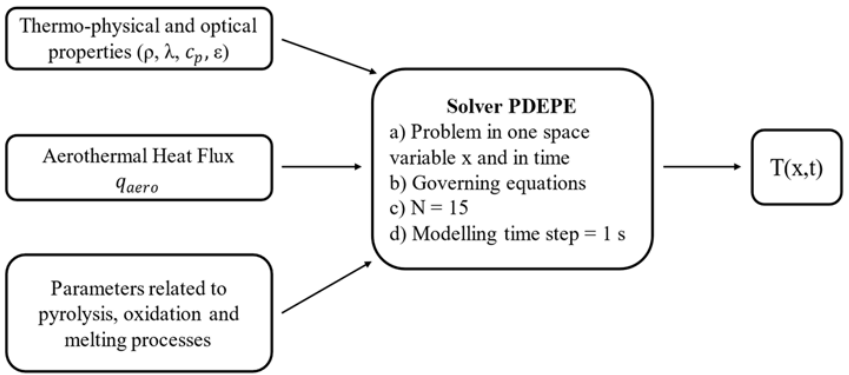
Figure 6. Numerical model implementation flow chart.